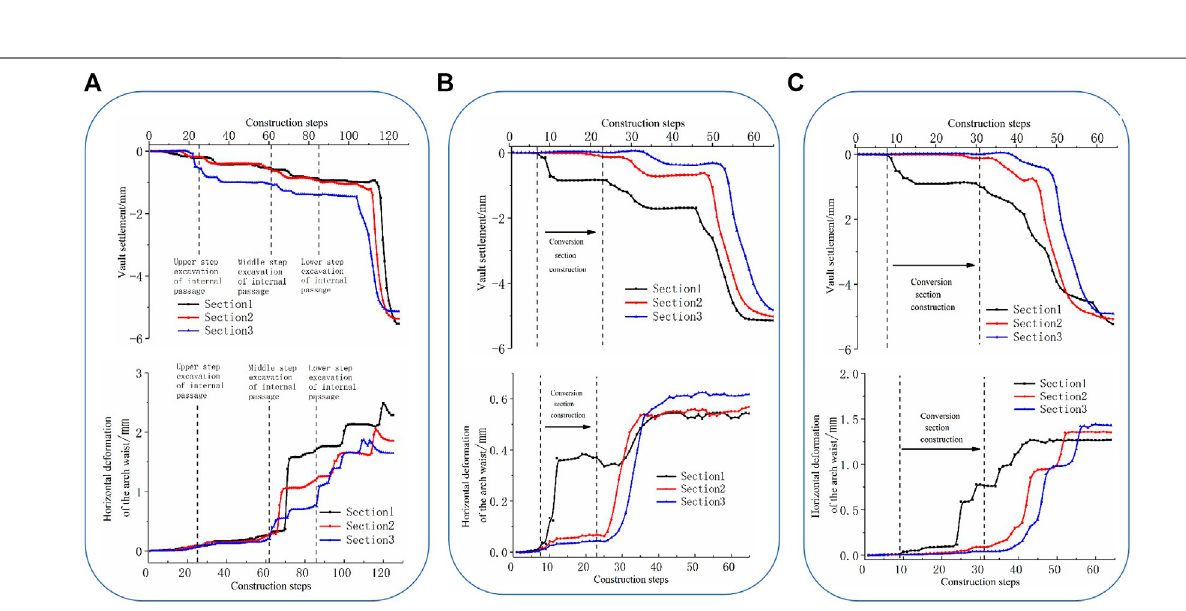
Frontiers in Earth Science |